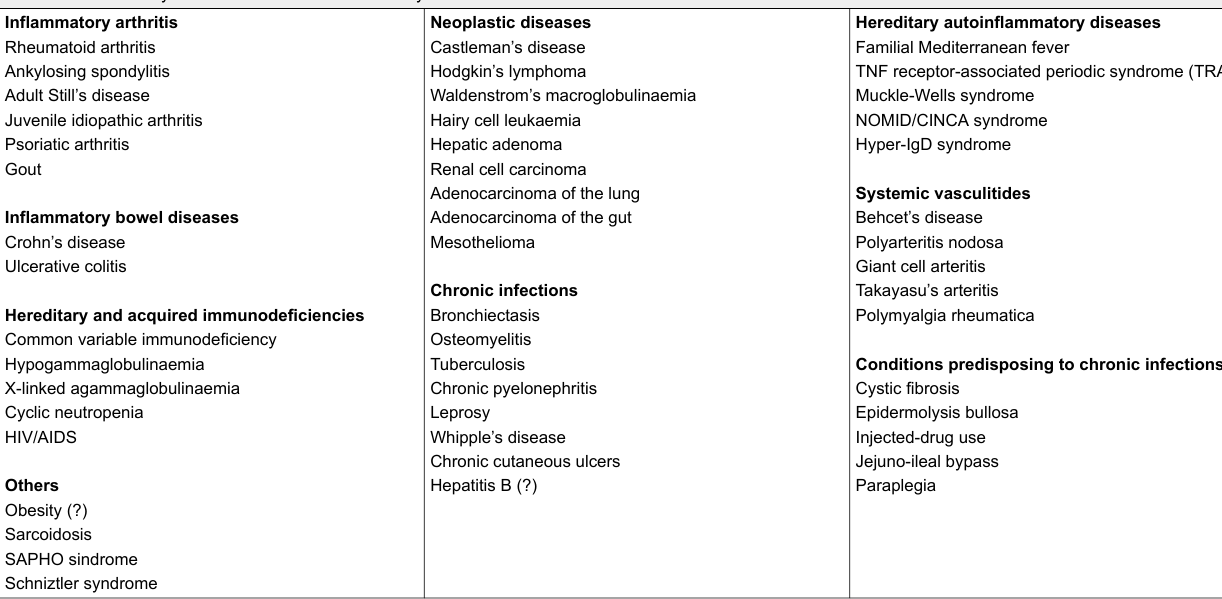
Table 1: Inflammatory diseases associated with AA